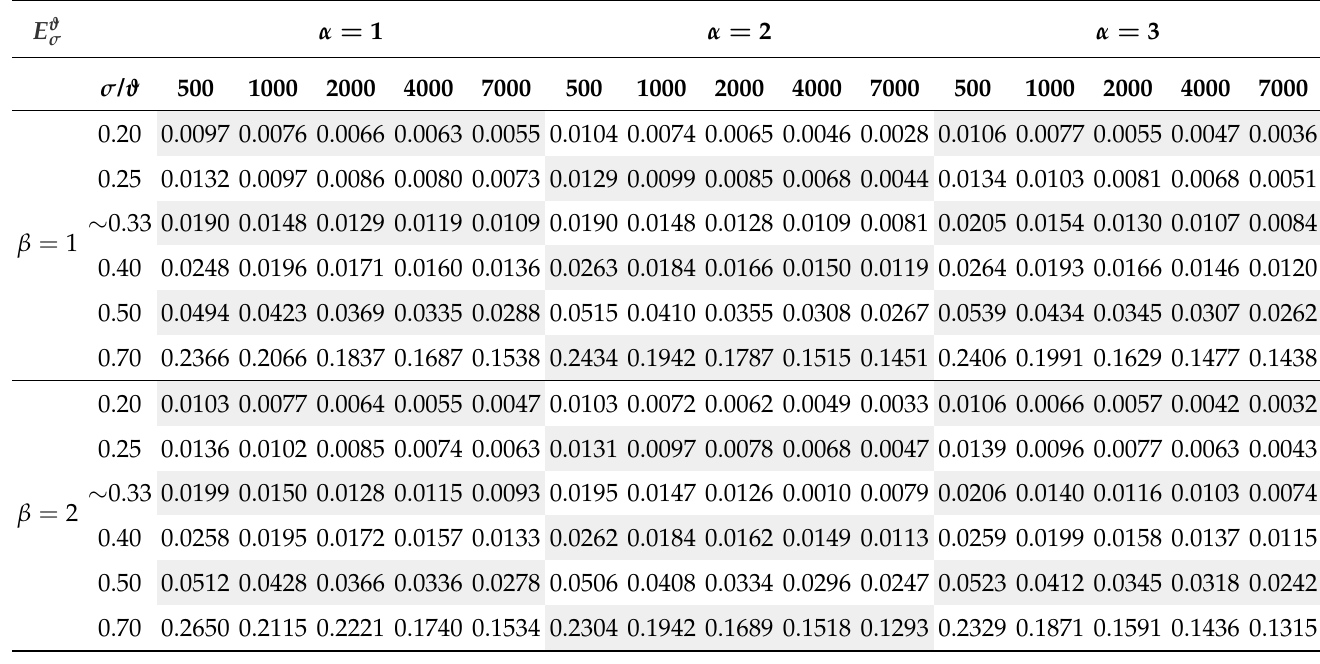
Table 1. DFN158. Table of the E ϑ σ values, varying ( σ , ϑ ) ∈ Σ × Θ , for each NN of architecture A α trained with configuration β , for each α = 1,2,3, and for each β =